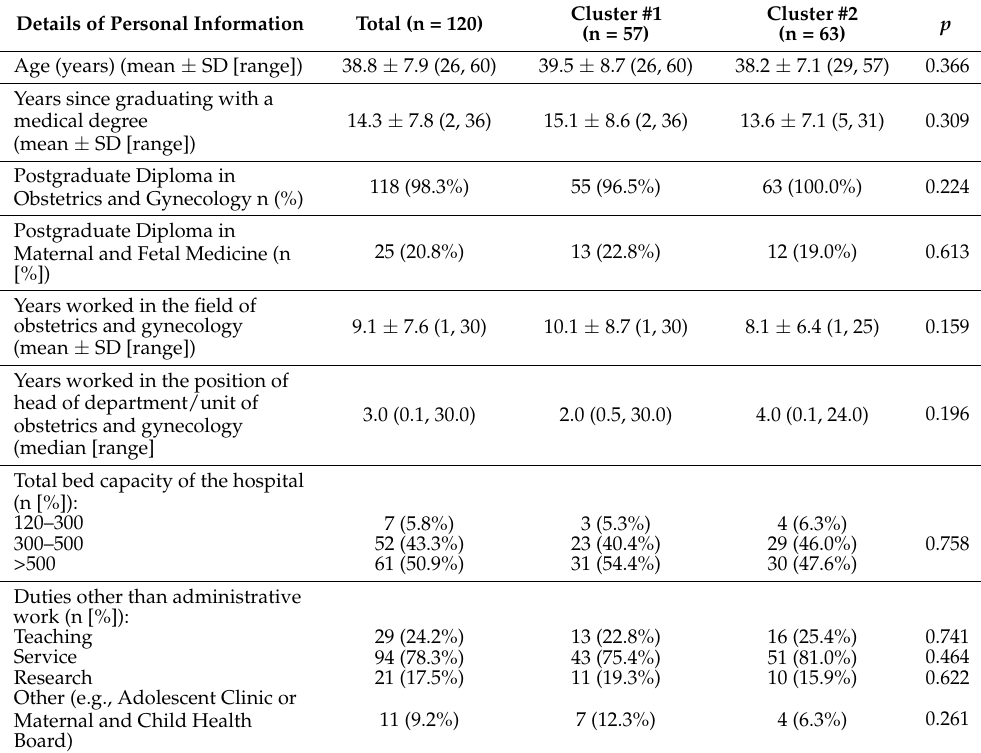
Table 1. Personal information (more than one option was able to be